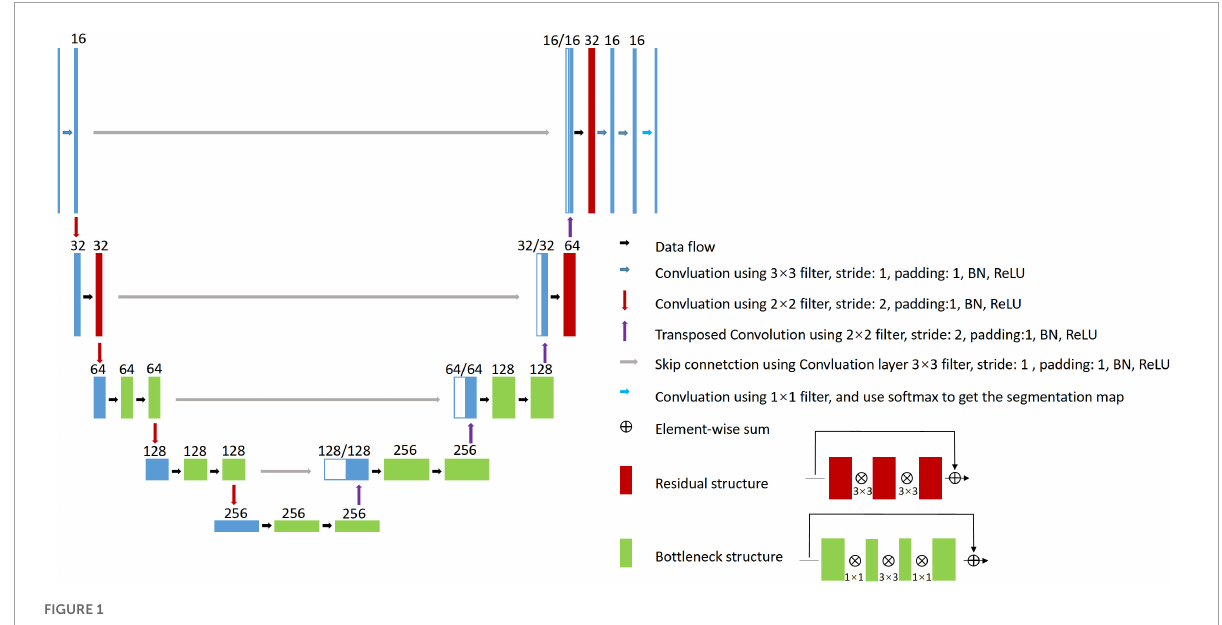
FIGURE1 Proposed 2D VB-Net architecture for WMH